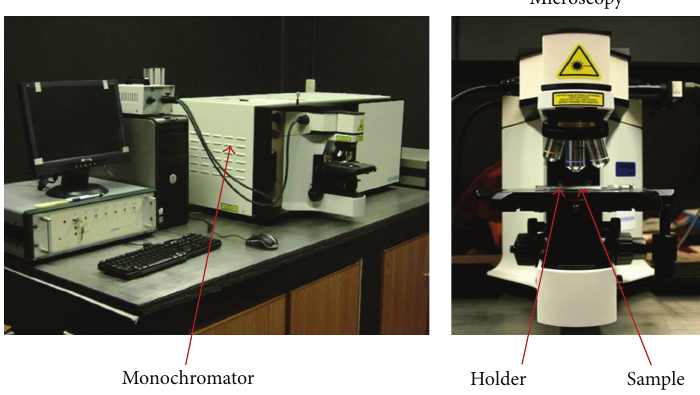
Figure 2: Raman system.